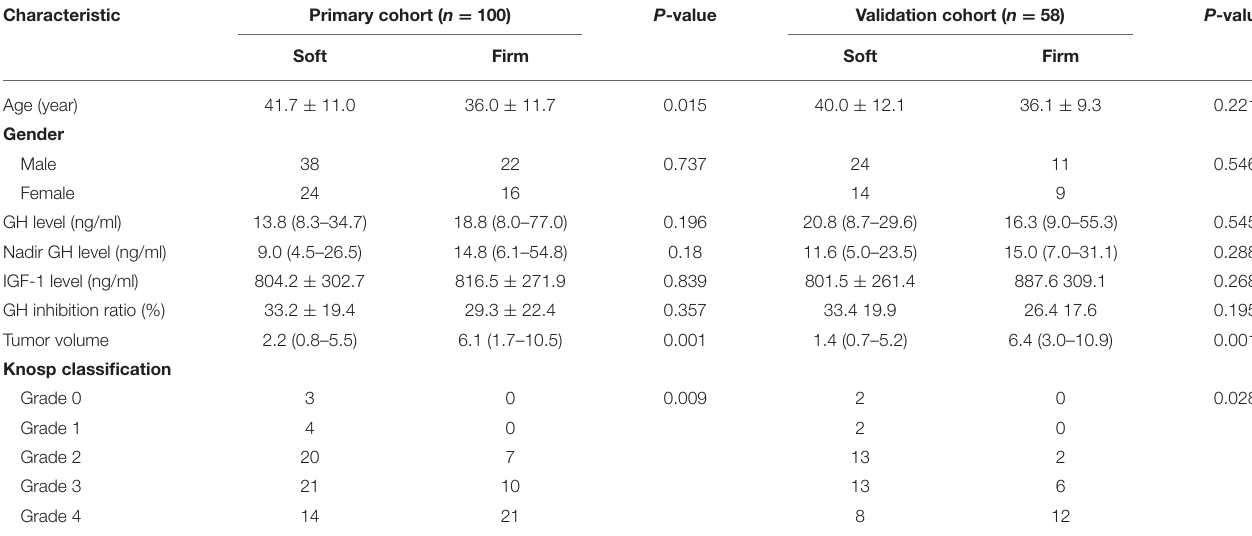
TABLE 2 | Univariate analysis of clinical characteristics of patients and acromegaly in the primary cohort and validation cohort. Characteristic